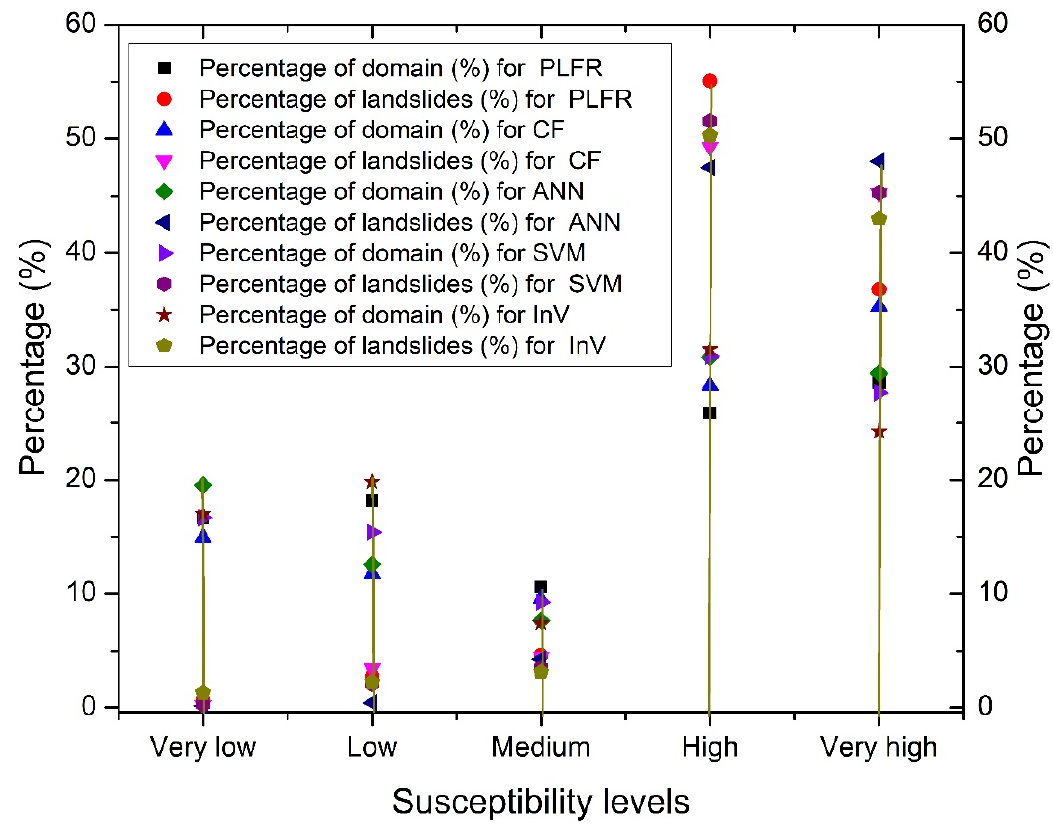
Figure 11. Comparison of the relative distribution of susceptibility levels using PLFR, InV, CF, ANN and SVM models, respectively.